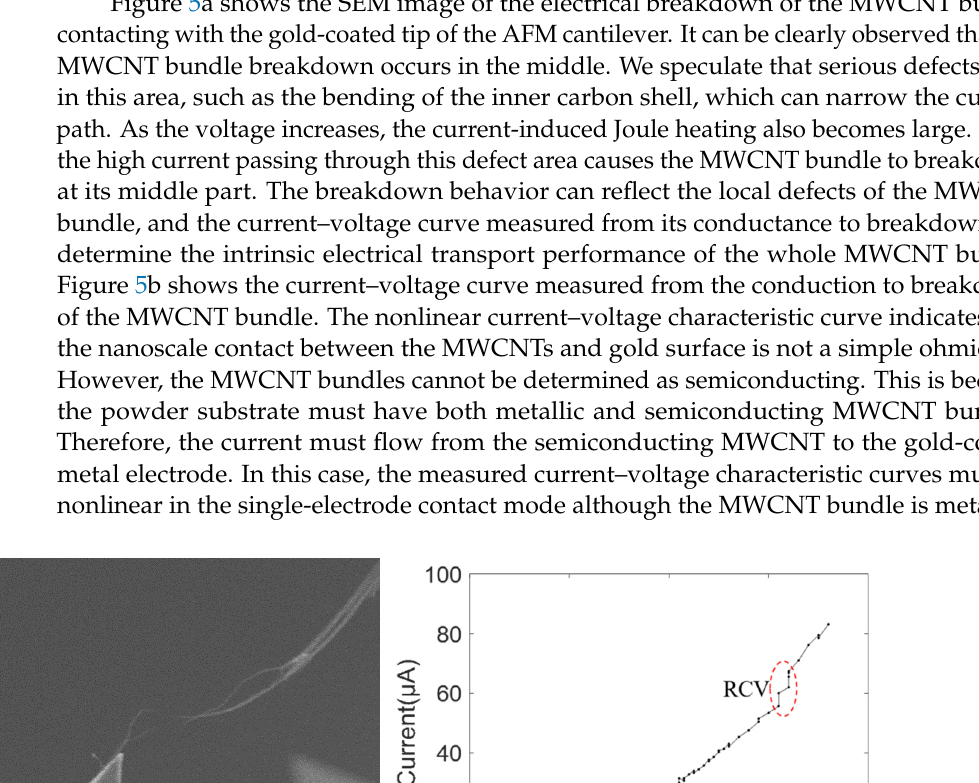
Figure 4. Resistance circuit model for MWCNT bundle.